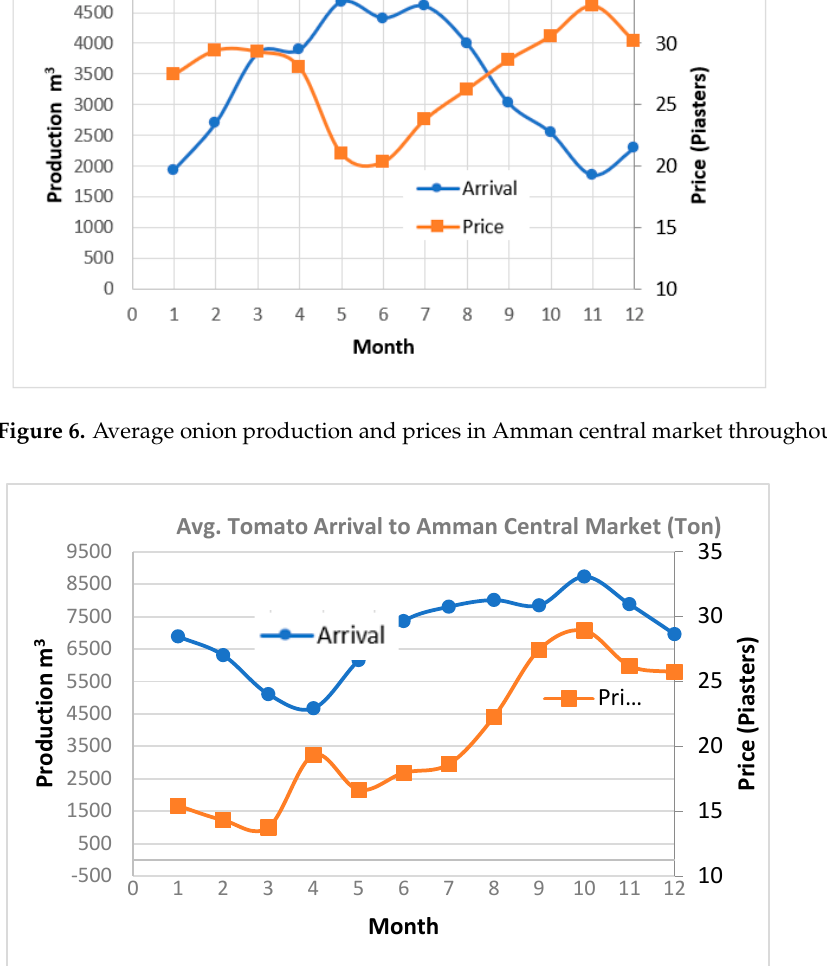
Table 4. Self-sufficiency ratio of cereal (2020) [34].